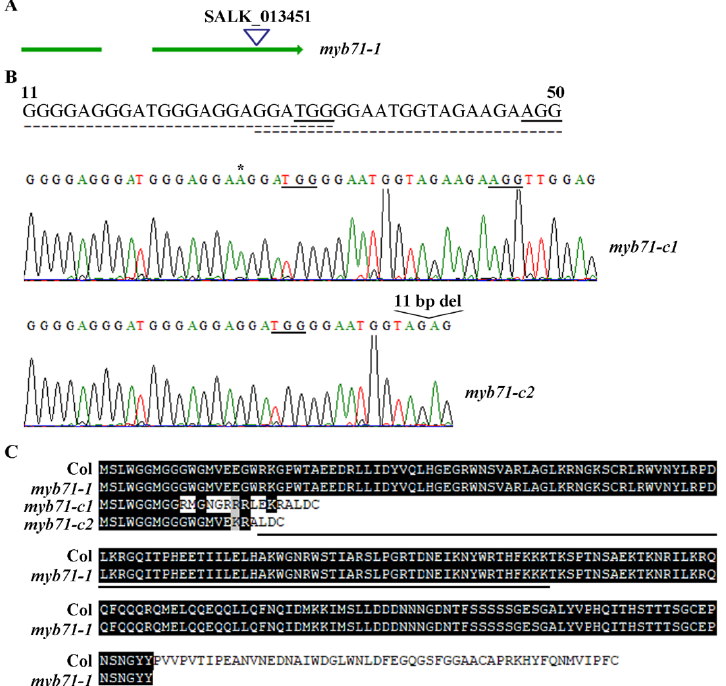
Figure 4. Isolation of T-DNA insertion mutant and generation of gene edited mutants of MYB71 . ( A ) T-DNA insertion position of the myb71-1 single mutant. Seeds of the SALK_013451 T-DNA insertion line were obtained from ABRC, and PCR was used to identify homozygous mutant. ( B ) Gene editing status of MYB71 in the myb71-c1 and myb71-c2 mutants. DNA was isolated from leaves of transgene- free T2 plants, and PCR was used to amplify the genome sequence of MYB71 . The PCR products were recovered and sequenced, and sequencing results were compared with genome sequence of MYB71 to check the editing status. Top panel shows the two overlapped target sequences. Dash lines indicate the target sequences, solid lines indicate the PAM sites, and star indicated the single nucleotide inserted. ( C ) Alignment of MYB71 amino acid sequence in the Col wild type and the MYB71 mutants. The open-reading frame (ORF) of MYB71 sequence in the myb71-c1 and myb71-c2 single mutants were identified by using ORFfinder (http://www.ncbi.nlm.nih.gov/orffinder/, accessed on 31 May 2019), and corresponding amino acid sequences were used for alignment with the amino acid sequence of MYB71 . The amino acid sequence for MYB71 in the myb71-1 mutant corresponding to the amino acids encode by the CDS before the T-DNA insertion. Underlines indicate the R2R3 MYB